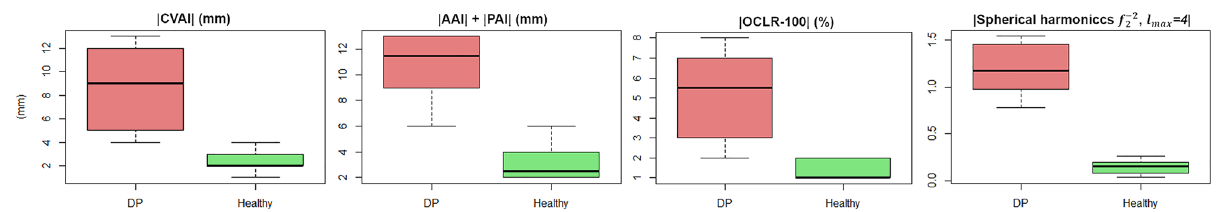
− 2 2 lmax = 4 for the